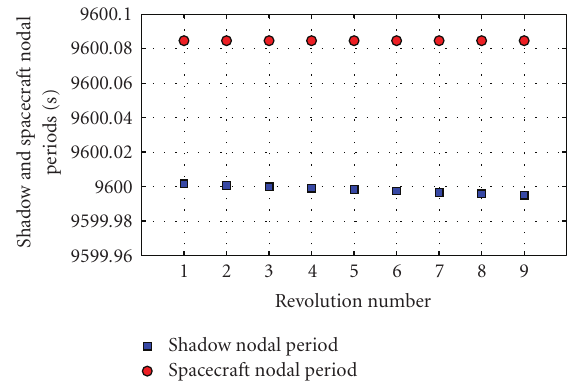
Figure 14: The di ff erence between the shadow nodal period and spacecraft nodal